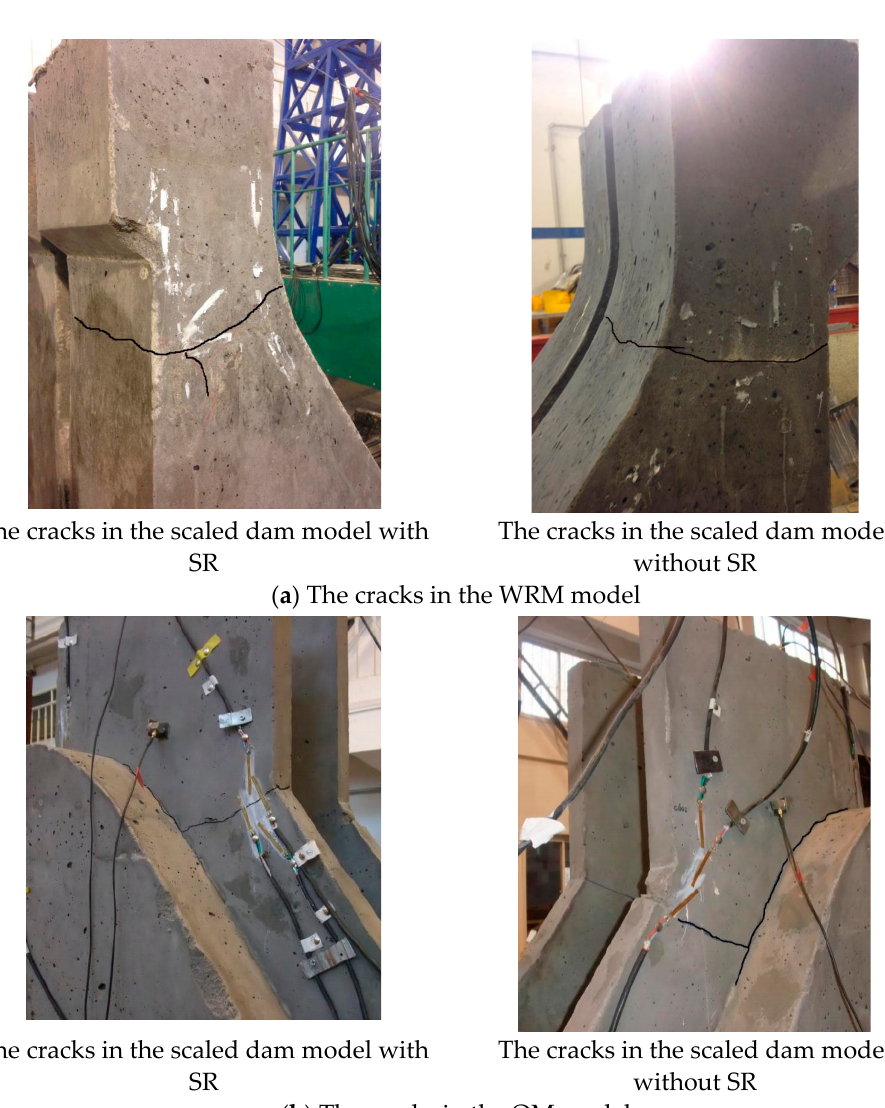
Figure 7. The cracks in the scaled dam models.